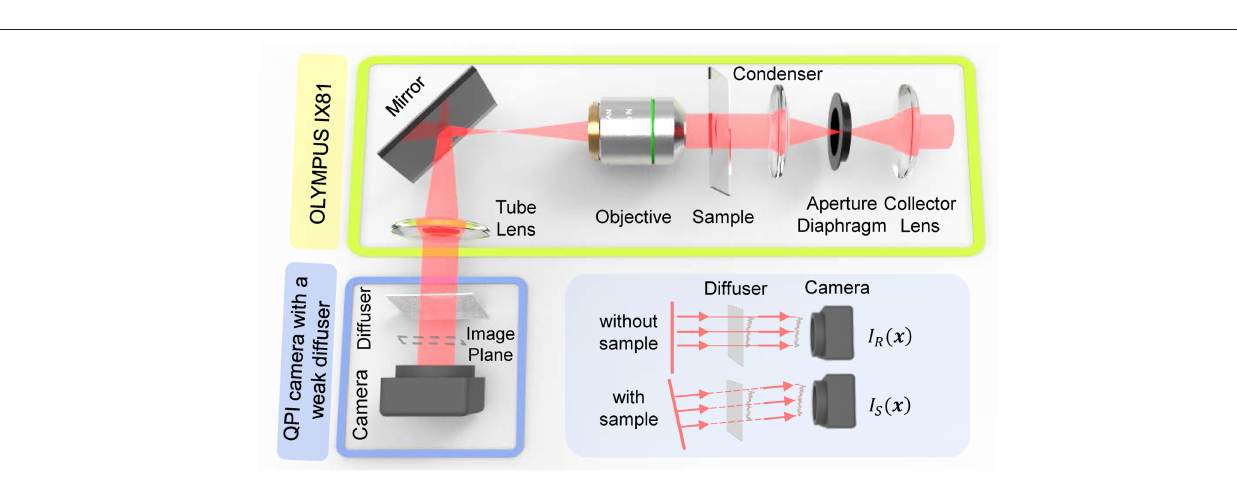
FIGURE 4 | The schematic of the experimental setup and principle of the QPICWD. For a weak diffuser, a tip or tilt angle to the impinging wavefront results in a global shift of the speckle